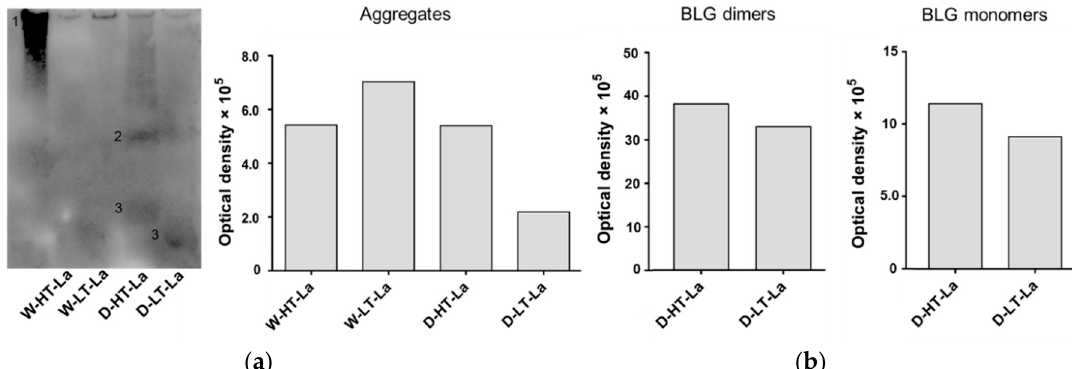
Figure 3. ( a ) Membrane image of CML western blot measured of BLG heated in the presence of lactose (La) in a wet system (W) or a dry system (D) at low temperatures (LT) or high temperatures (HT). G90: soy protein extract glycated with glucose for 90 min (positive control). Numbers indicate aggregates (1), BLG dimers (2), and BLG monomers (3). ( b ) Optical density of bands visible on the CML western blot categorized in high-MW aggregates, BLG dimers, and BLG monomers as indicated on the membrane.